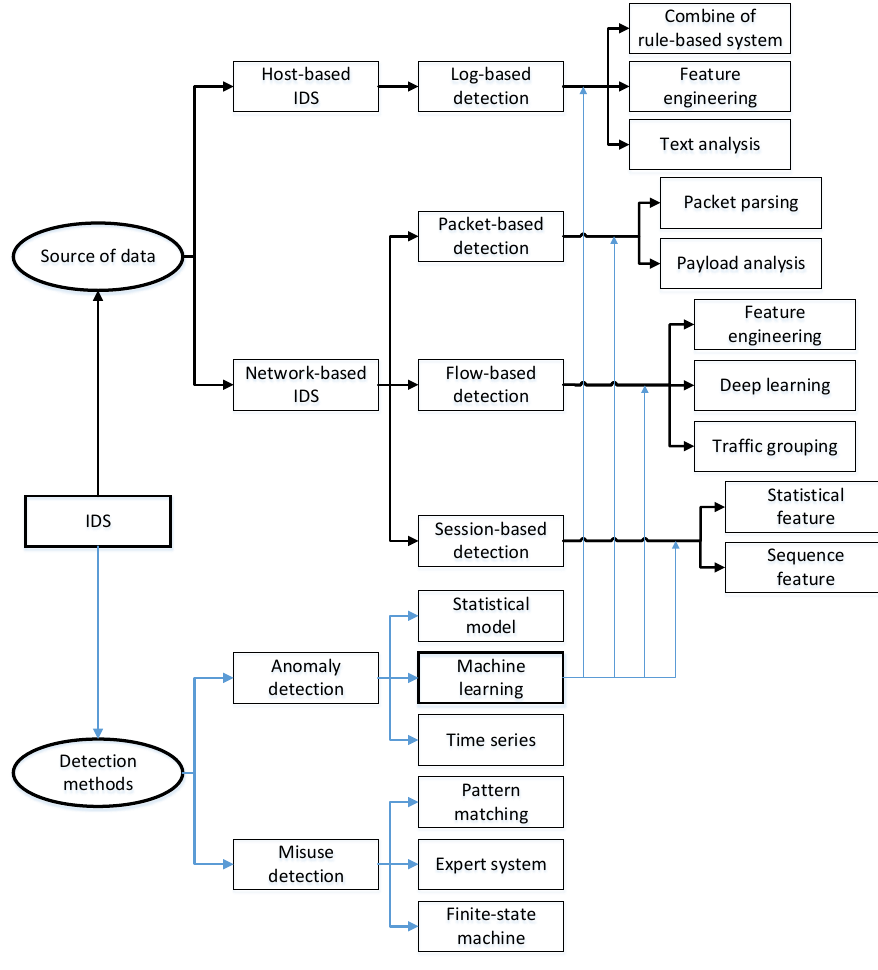
Figure 1. Taxonomy system of